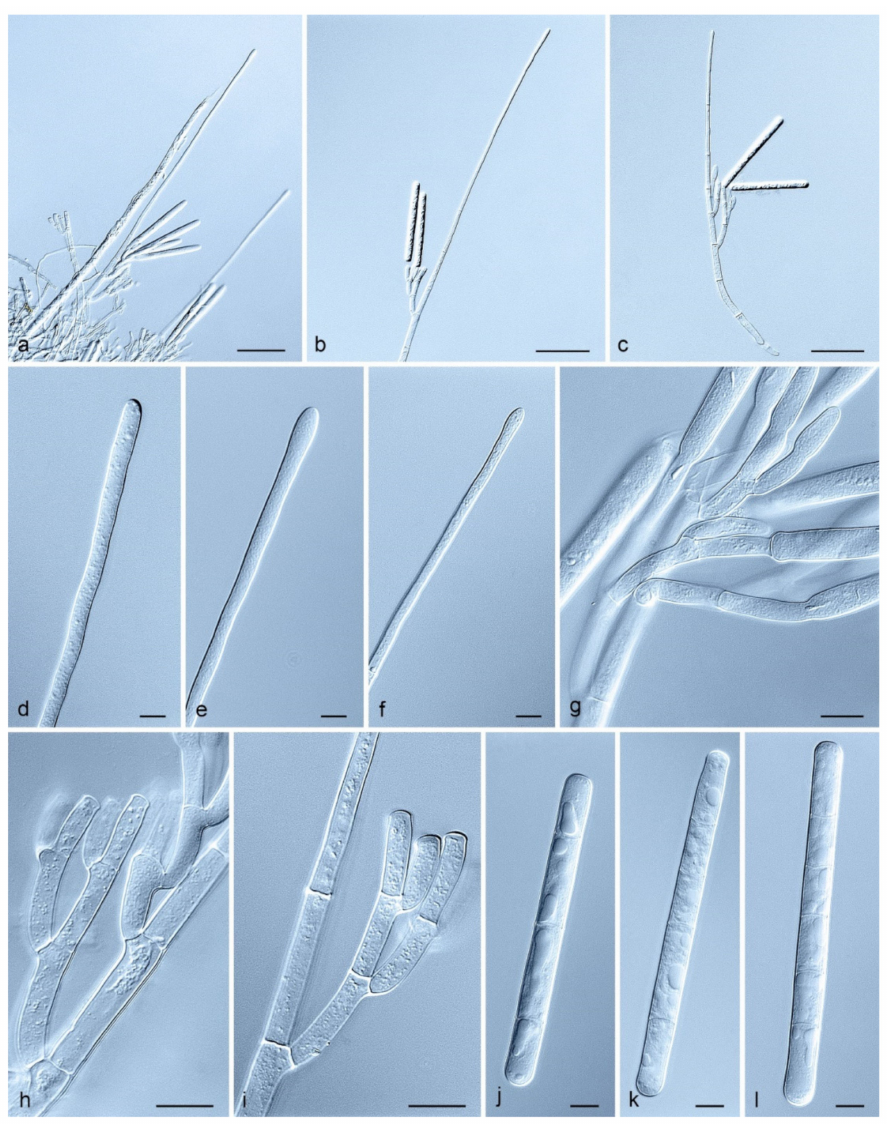
Figure A12. Calonectria pseudoreteaudii . ( a – c ). Macroconidiophore; ( d – f ). clavate to narrowly clavate vesicle; ( g – i ) conidiogenous apparatus with conidiophore branches and cylindrical to allantoid phialides; ( j – l ). macroconidia.—Scale bars: a–c = 20 µ m; d–f = 5 µ m; g–l = 10 µ